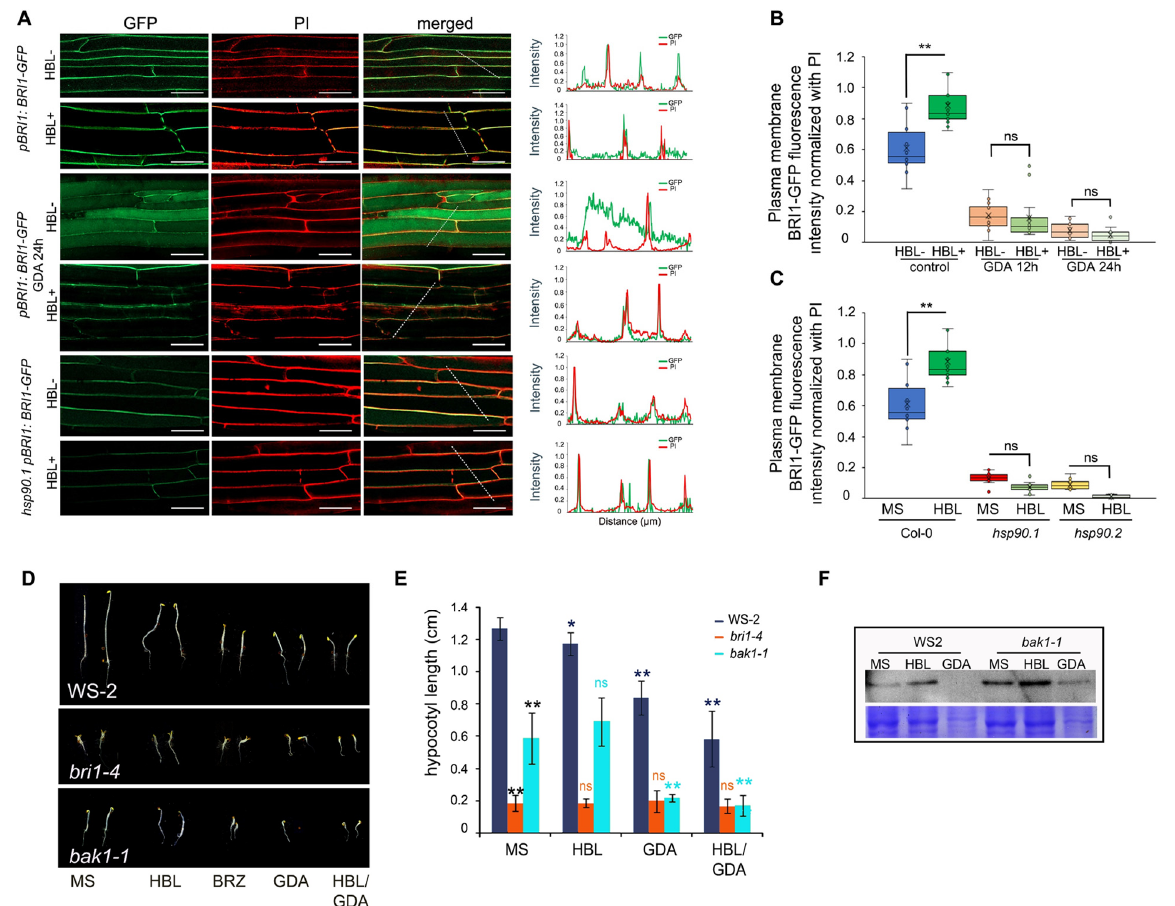
Figure 3. Impaired HSP90 function affects BRI1 protein levels at the plasma membrane of hypocotyl cells. ( A ) BRI1:BRI1-GFP localization in hypocotyl cells of 5-d-old, etiolated wild-type seedlings growing under control conditions or after treatment with 10 µ M GDA for 24 h or hsp90.1 mutant in resting conditions and upon the exogenous application of 100 nM HBL. The white lines mark the cells used for the quantification of the fluorescence signal intensity presented in plot profiles at the right of the images, generated by normalized values of fluorescence intensity. Propidium iodide (PI) cell wall stain was used to visualize the cell patterns in etiolated hypocotyls. Scale bars, 20 µ m. ( B , C ) Quantification of relative plasma membrane (PM) fluorescence intensity of untreated and treated with 10 µ m GDA BRI1-GFP hypocotyls ( B ) and hsp90.1 and hsp90.2 mutants ( C ) , in the absence or presence of 100 nM HBL. PM fluorescence intensity was normalized to background fluorescence for each measurement (n = 30). In box plots, the middle line in the box represents median, the × shows mean, the bottom line depicts the 1st quartile, while the top line describes the 3rd quartile; the vertical lines (whiskers) extend to the minimum and maximum value within the 1.5 × interquartile range (distance between the 1st and the 3rd quartile); points outside of the whiskers mark outliers (values outside of the 1.5 × interquartile range). Data were analyzed with ANOVA followed by Tukey’s test, ** is significant at p < 0.01, ns is non-significant. ( D ) Images of 5-day-old etiolated WS-2, bak1-1, and bri1-4 seedlings grown in the presence of 60 nM HBL, 2 µ M GDA and 60 nM HBL or 2 µ M GDA. Scale bars, 0.5 cm. ( E ) Hypocotyl length sensitivity of 5-day-old etiolated WS-2, bak1-1 and bri1-4 seedlings grown under the indicated conditions. Data are presented as means ± SD (n > 30). Data were analyzed with one-way ANOVA followed by Tukey’s test, ** is significant at p < 0.01, * is significant at p < 0.05, ns is non-significant. ( F ) Western blot analysis using anti-BRI1 antibody. Proteins were extracted from 5-day-old etiolated seedlings of WS-2, bri1-4, or bak1 -1 treated for 4 h with 60 nM HBL or 2 µ M GDA. CBB staining served as loading